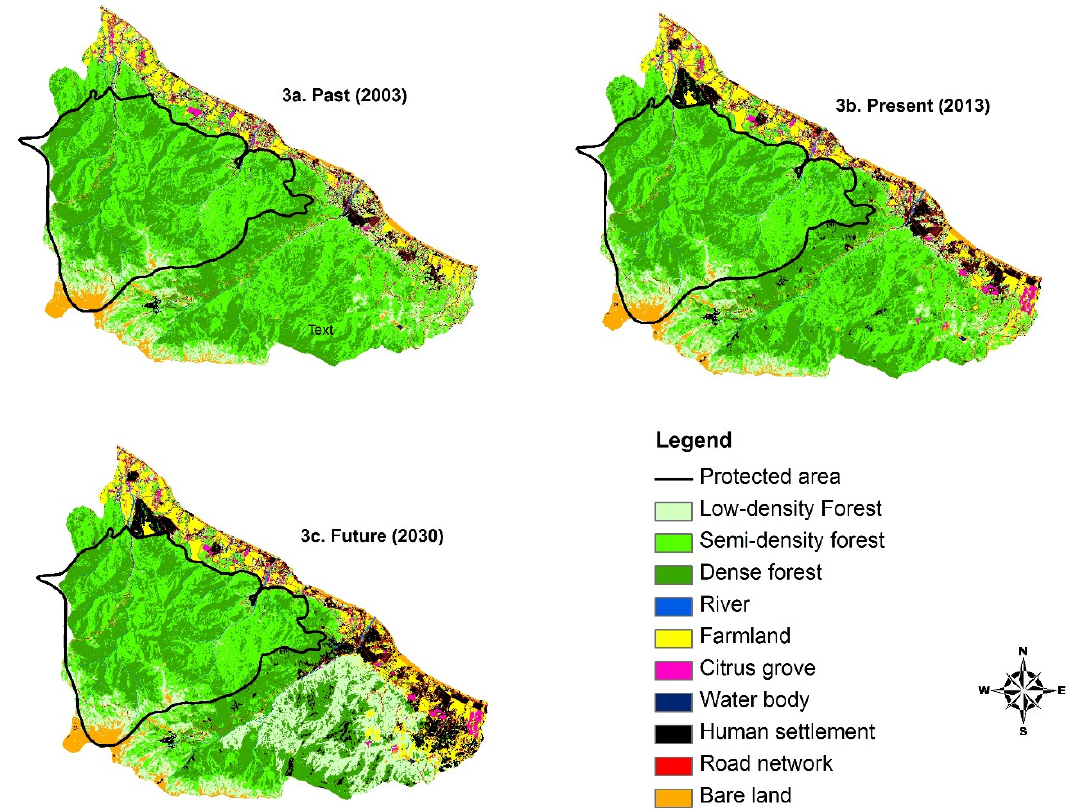
Figure 3. Past land use/land cover (LULC) ( a ); present, LULC ( b ); and plausible future LULC, if the current situation of LULC change continues ( c ) for the Sarvelat and Javaherdasht district.